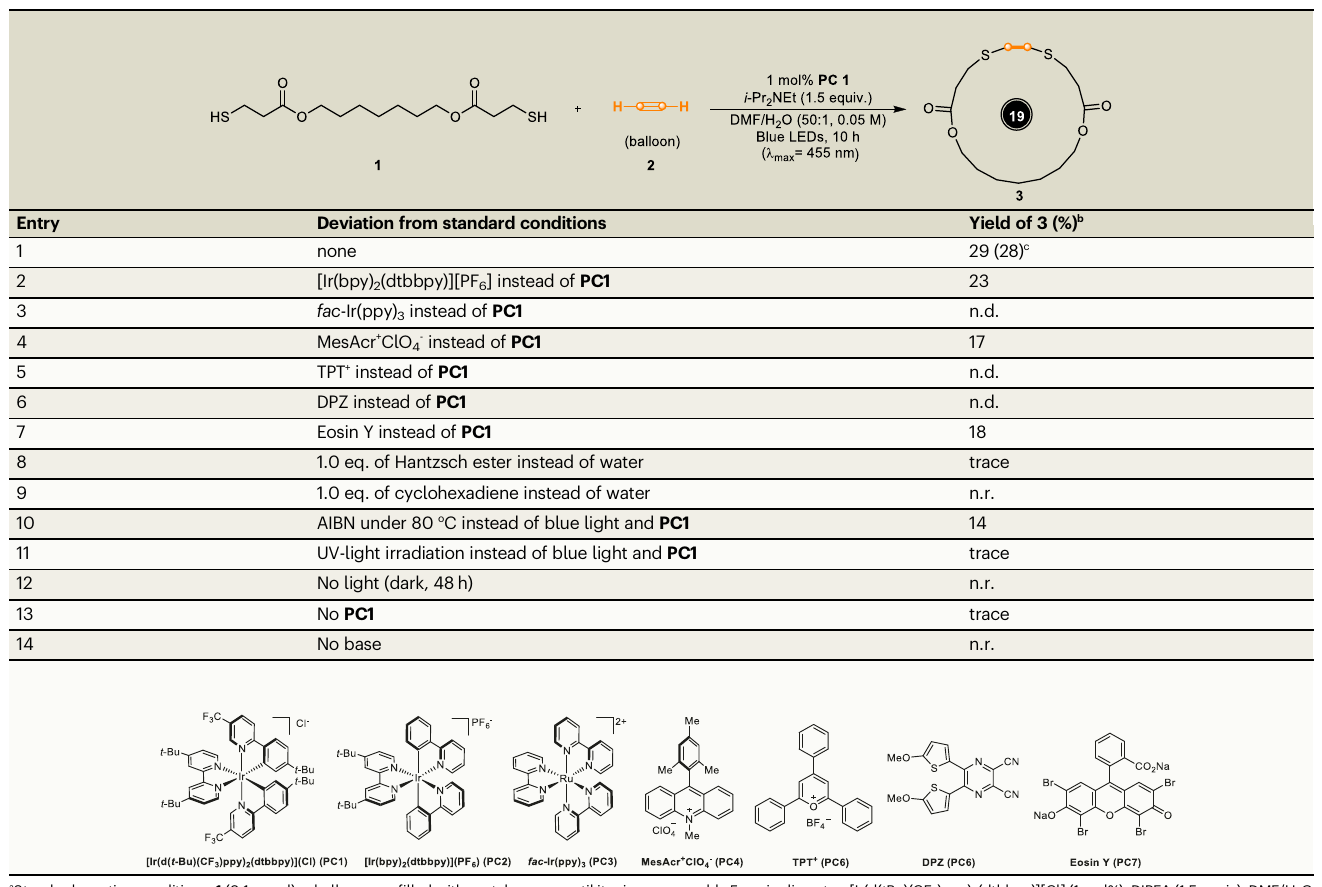
Table 1 | Optimization of the reaction conditions